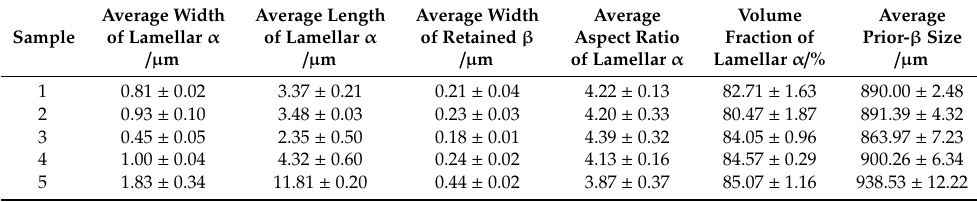
Table 3. Statistical microstructural features of TC4F after heat